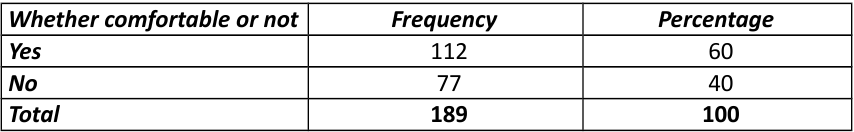
Table 1. Teaching Methods Used By Chemistry